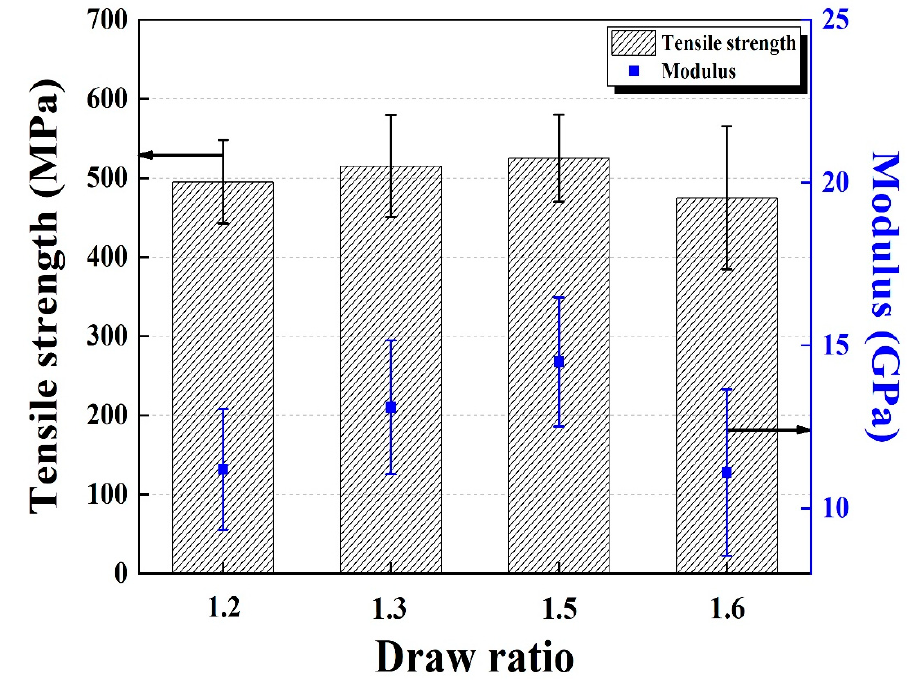
Figure 4. Tensile strength and initial modulus of LDPE / HDPE sheath-core fibers manufactured at different at draw ratio of 1.2–1.6 times.